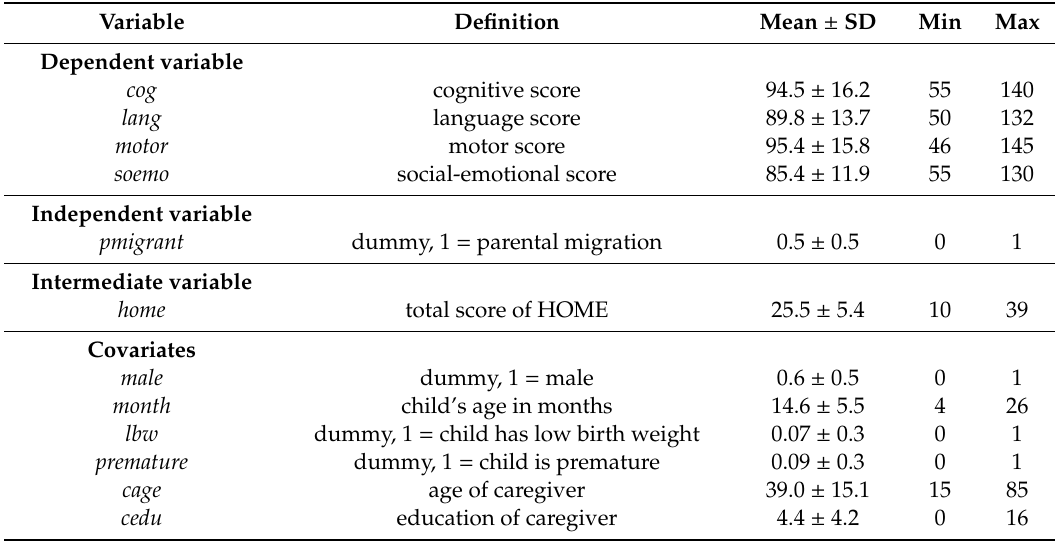
Table 1. Descriptive statistics.